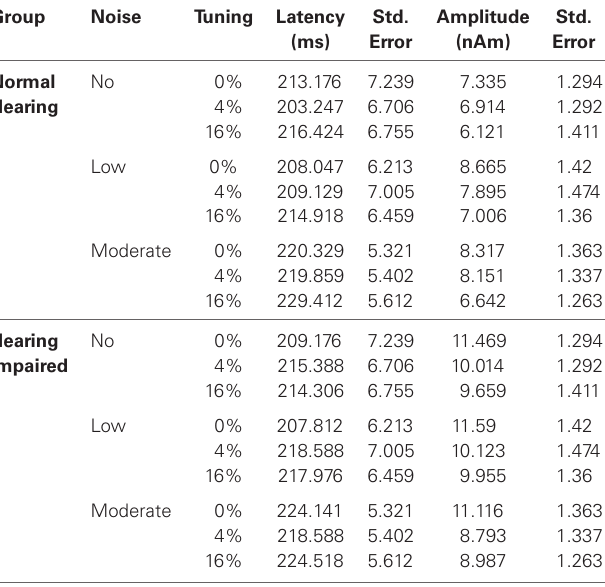
Table 2 | Group mean N1m latency and amplitude. Group